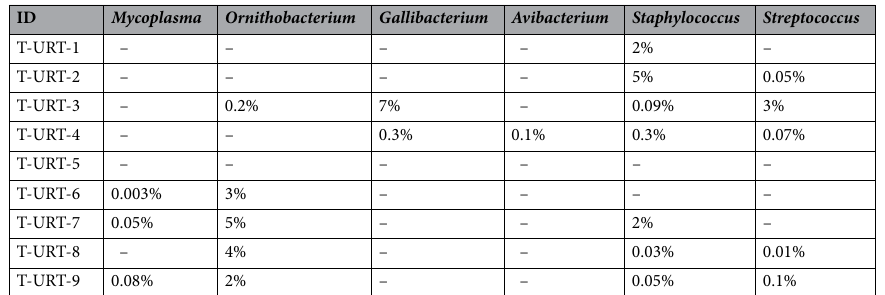
Table 1. Relative abundance of selected OTUs at the genus level in turkeys